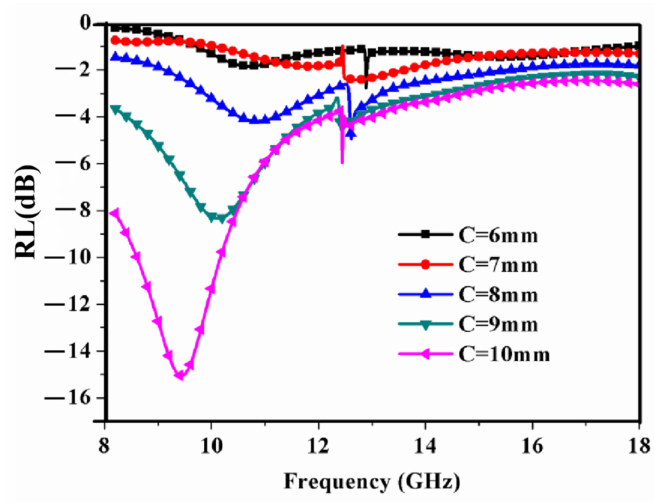
Figure 5. Simulated reflection loss of the RAM versus frequency for different C , a = 2 mm, t = 2 mm.